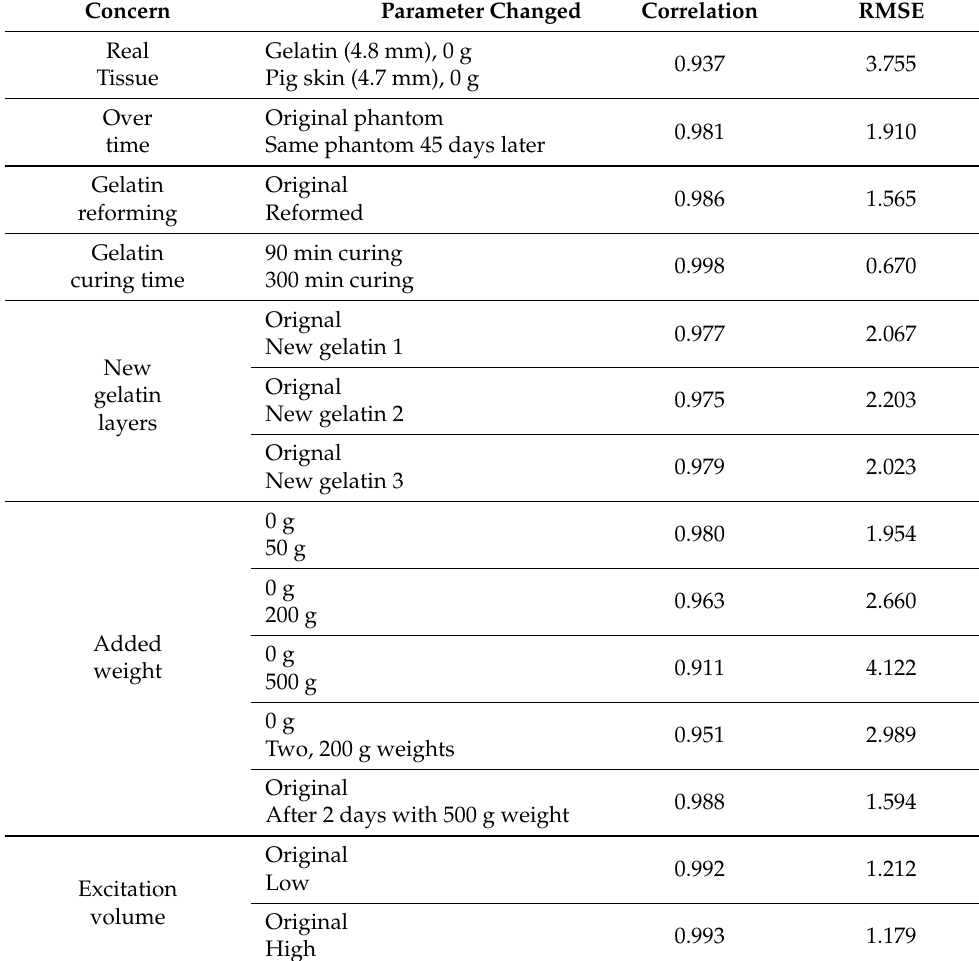
Table 3. The average correlation and RMSE measured between phantoms with a parameter